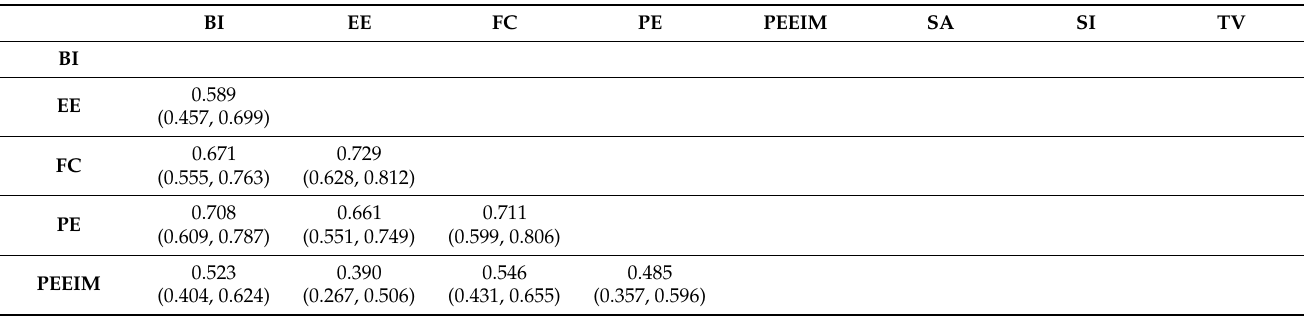
Table 4. Heterotrait–monotrait assessment for testing discriminant